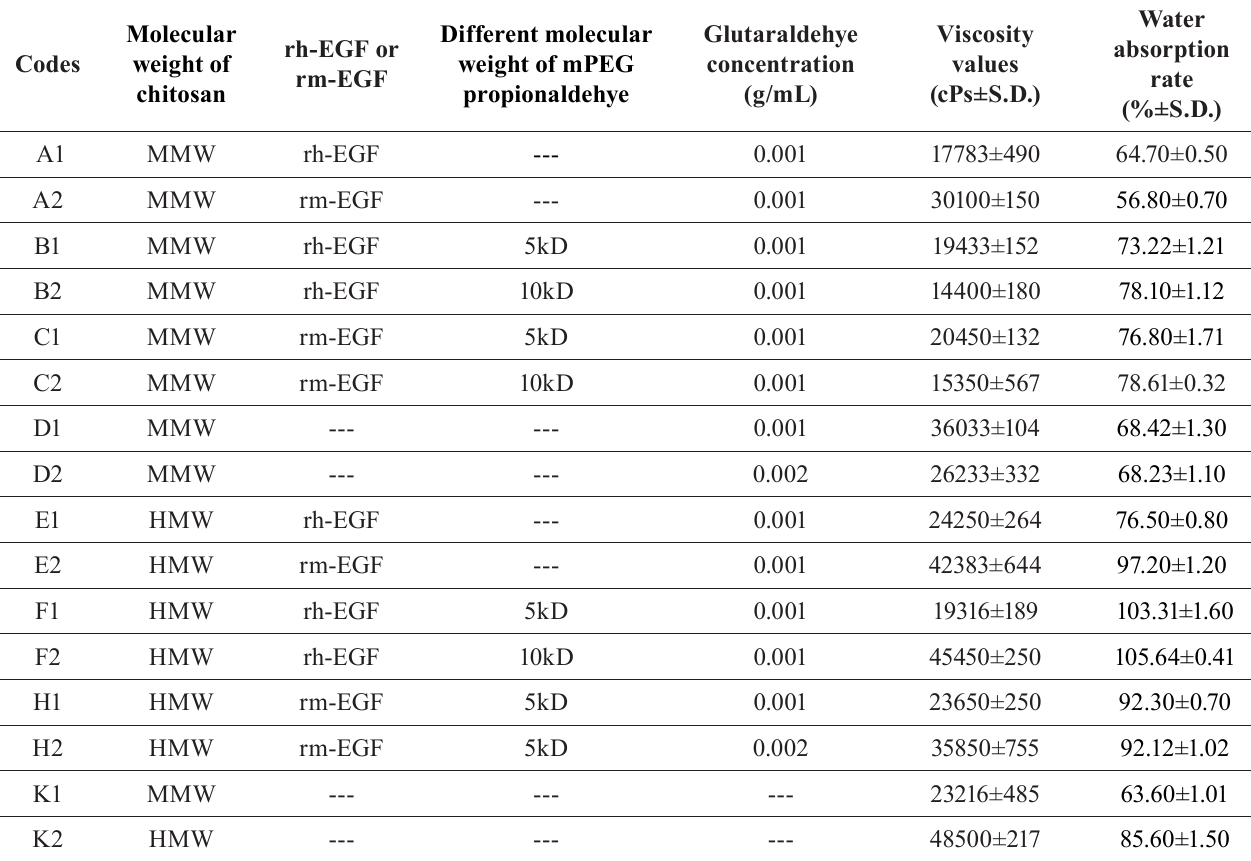
All hydrogel formulations contain polyvinil alcohol (PVA, 2%). MMW and HMW indicate medium molecular weight and high molecular weight respectively. rh-EGF: recombinant human epidermal growth factor. rm-EGF: recombinant mouse epidermal growth